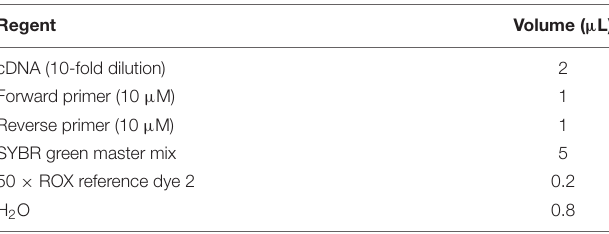
TABLE 2 | Real time fluorescence quantitative PCR reaction.